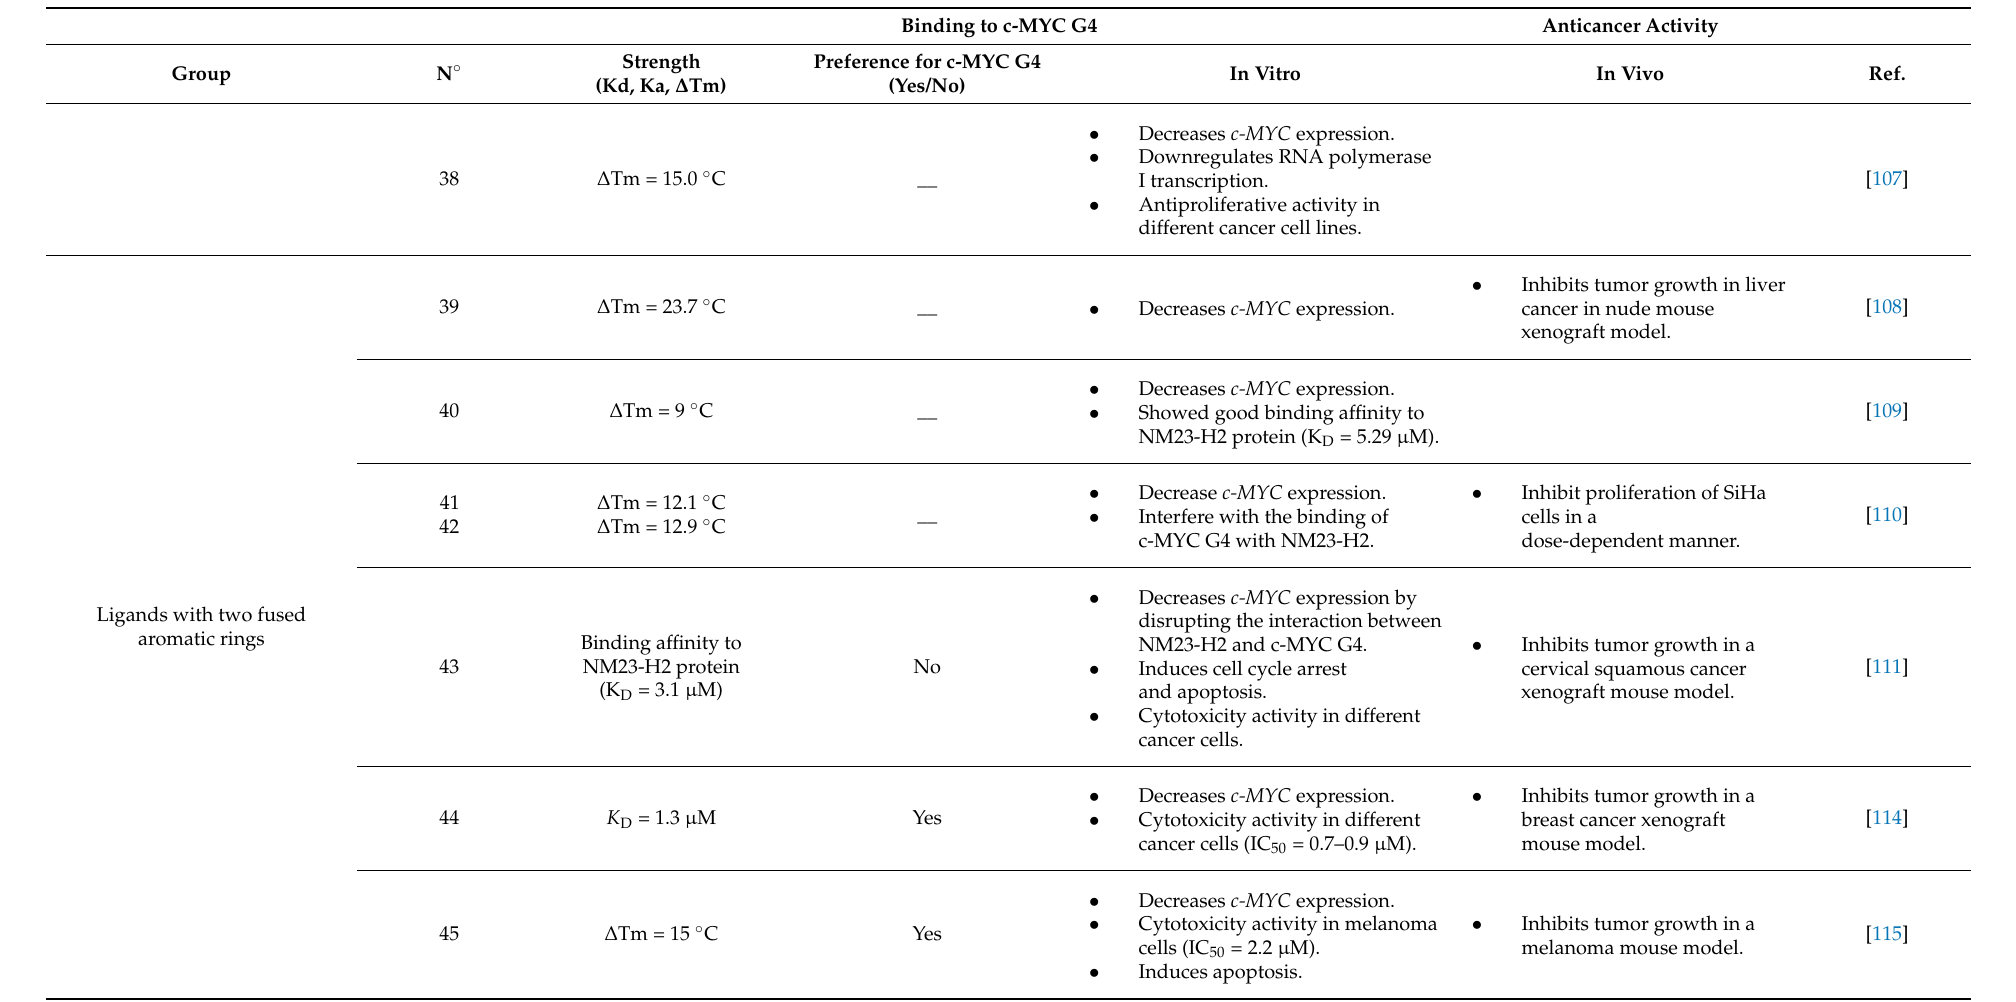
Binding to c-MYC